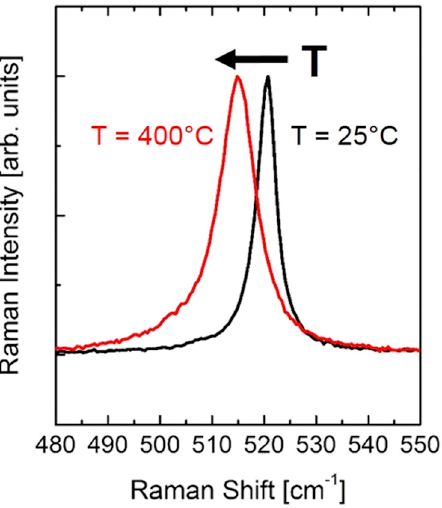
Figure 2. Raman spectrum of polycrystalline silicon at 25 °C and ~400 °C, as collected on the µhps. Increasing T produces a shift of the Raman line position and a broadening of the linewidth.